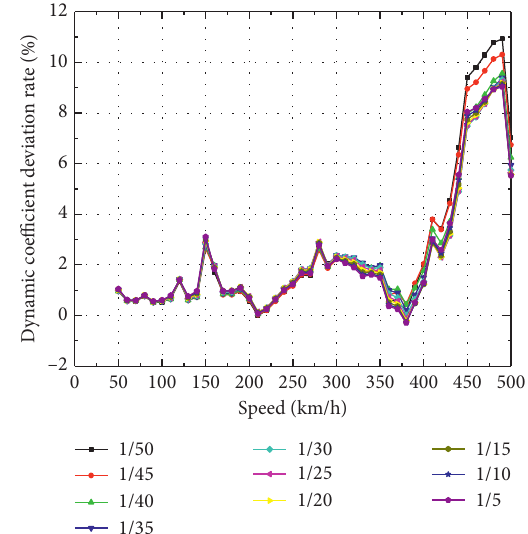
Figure 15: Dynamic coefficient deviation rate of the bridge under the moving mass model.